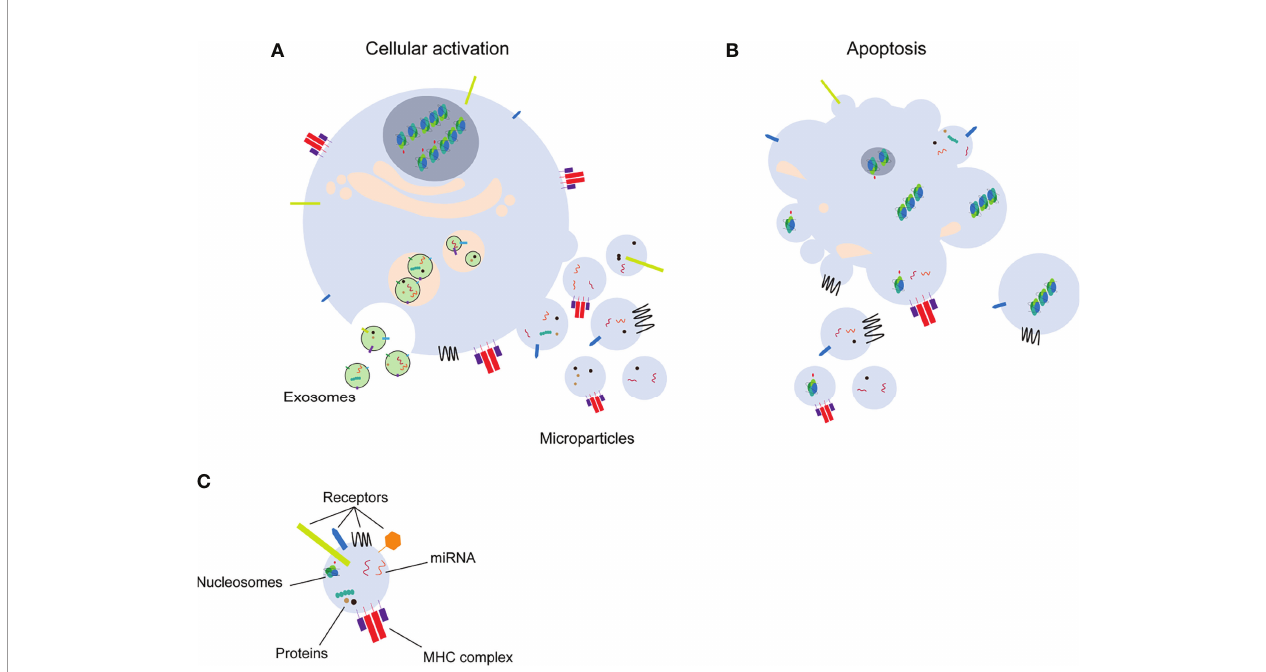
FIGURE 1 | Distinct classes of extracellular vesicles. Upon cell activation (A) exosomes or microparticles are formed by exocytosis or membrane shedding, respectively. Microparticles and apoptotic bodies (B) are released from apoptotic cells. Extracellular vesicles transfer several molecules to target cells (C) . miRNA: microRNA, MHC: major histocompatibility